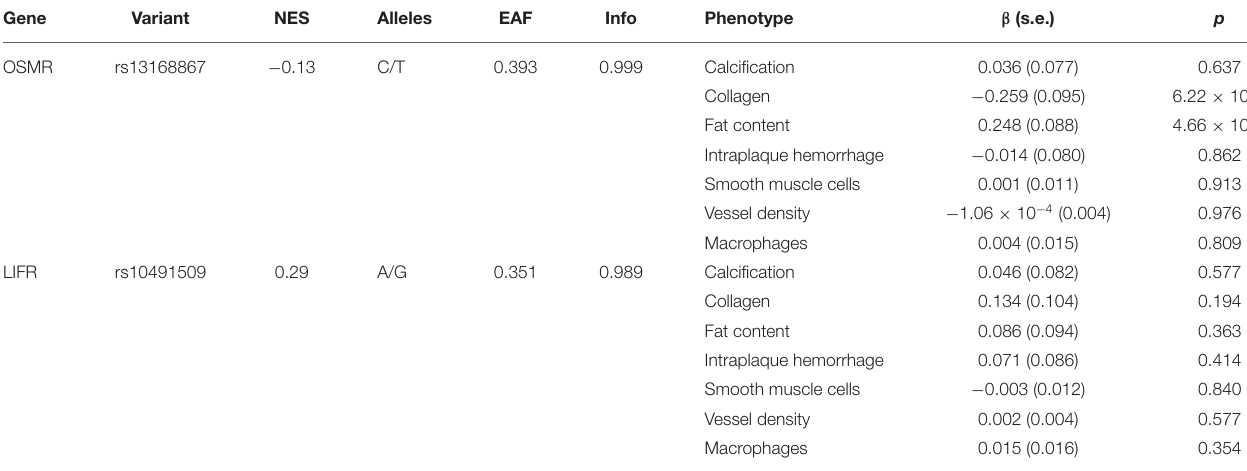
TABLE 2 | OSMR and LIFR variants and their association with plaque phenotypes. Gene Variant NES